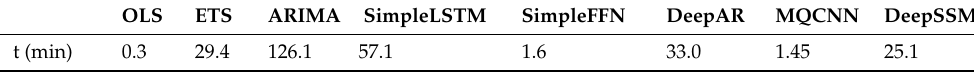
Table 3. Processing time (minutes) of the performance evaluation, reported per algorithm,